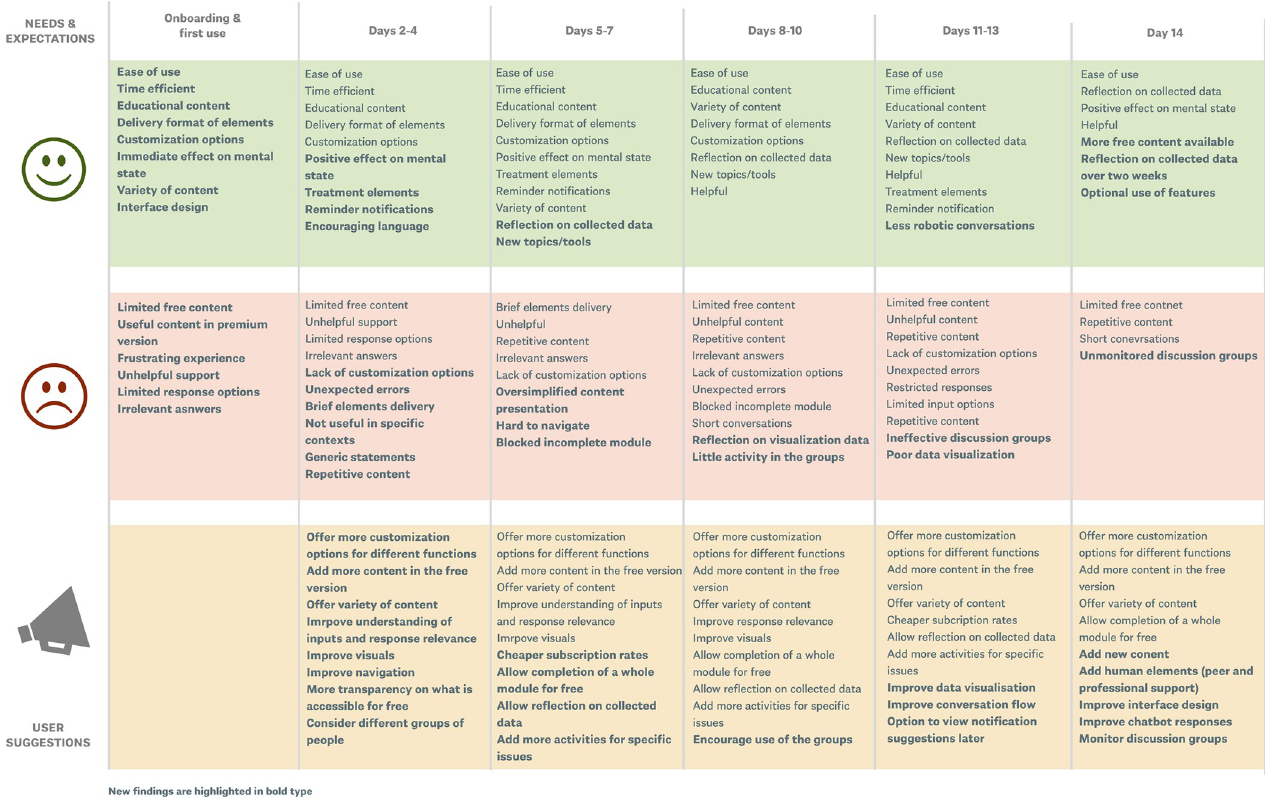
Fig 3. Experience